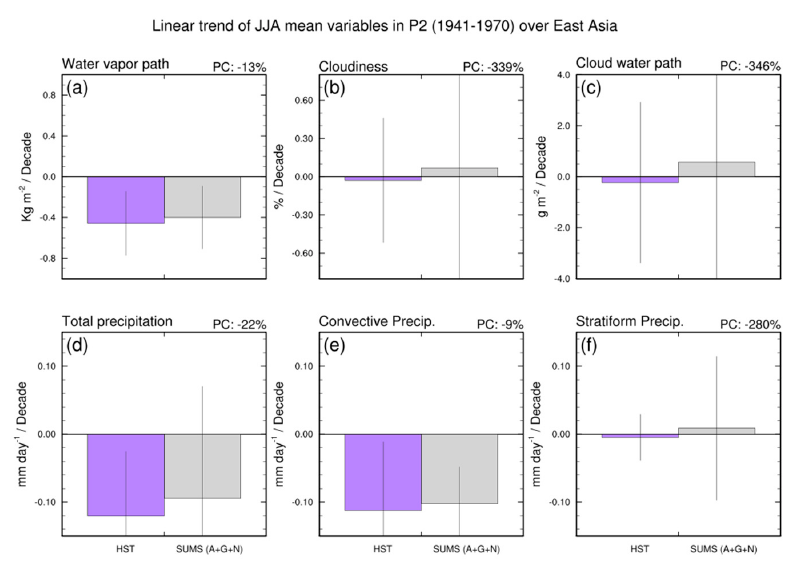
Figure 10. The linear trends of the JJA-mean variables; ( a ) water vapor path; ( b ) total cloud fraction; ( c ) cloud water path; ( d ) total precipitation rate; ( e ) convective precipitation rate; ( f ) stratiform precipitation rate; in combined all-forcing runs (HST; purple bar) and the sum of single-forcing simulations (anthropogenic aerosol, GHGs, and natural forcing; gray bar) for P2 (1941–1970) over East Asia (20 ◦ –50 ◦ N and 110 ◦ –140 ◦ E). Error bars indicate the standard deviation of CMIP5 models MME. The percentage change PC in % {(HST-SUMS) /| HST | } has been shown in the right corner.